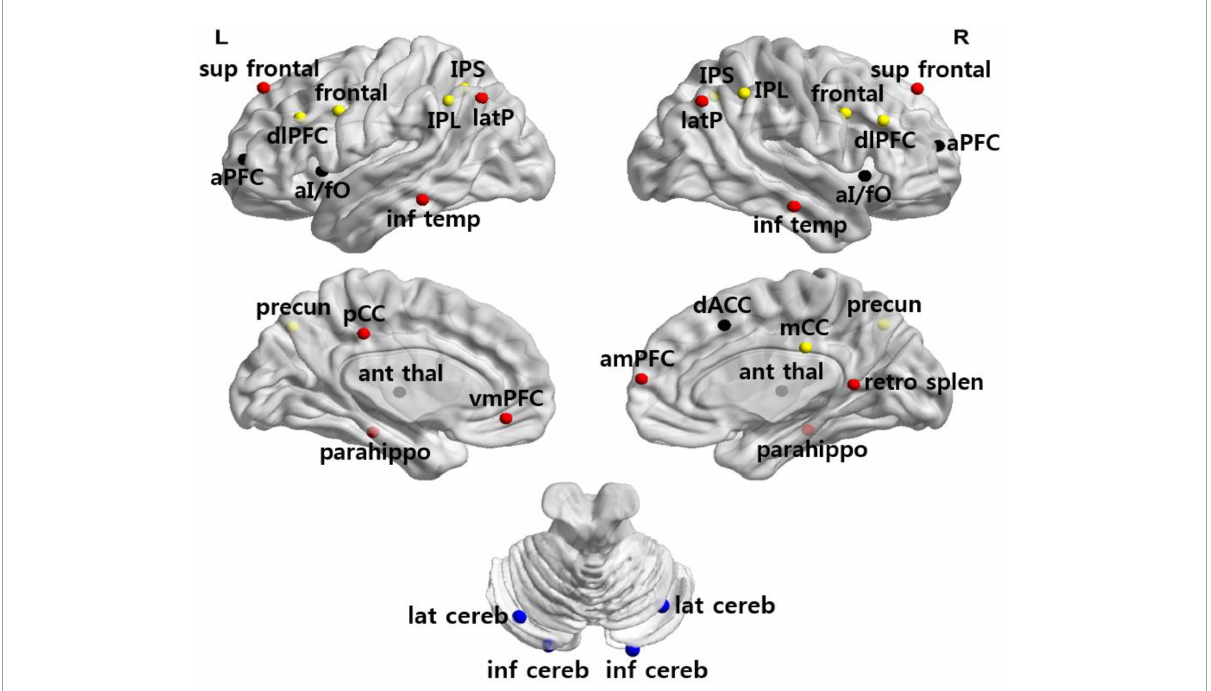
FIGURE1 Anatomical location of ROI. Regions are colored by network membership (yellow, FPN; black, CON; red, DMN; blue, CBN) and overlaid on a cortical